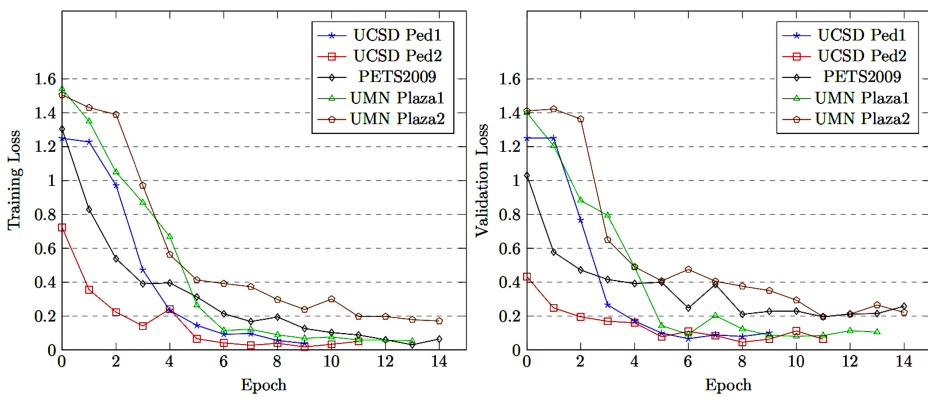
Figure 6. Training and validation loss of MCMS-BCNN-Attention + densenet121.